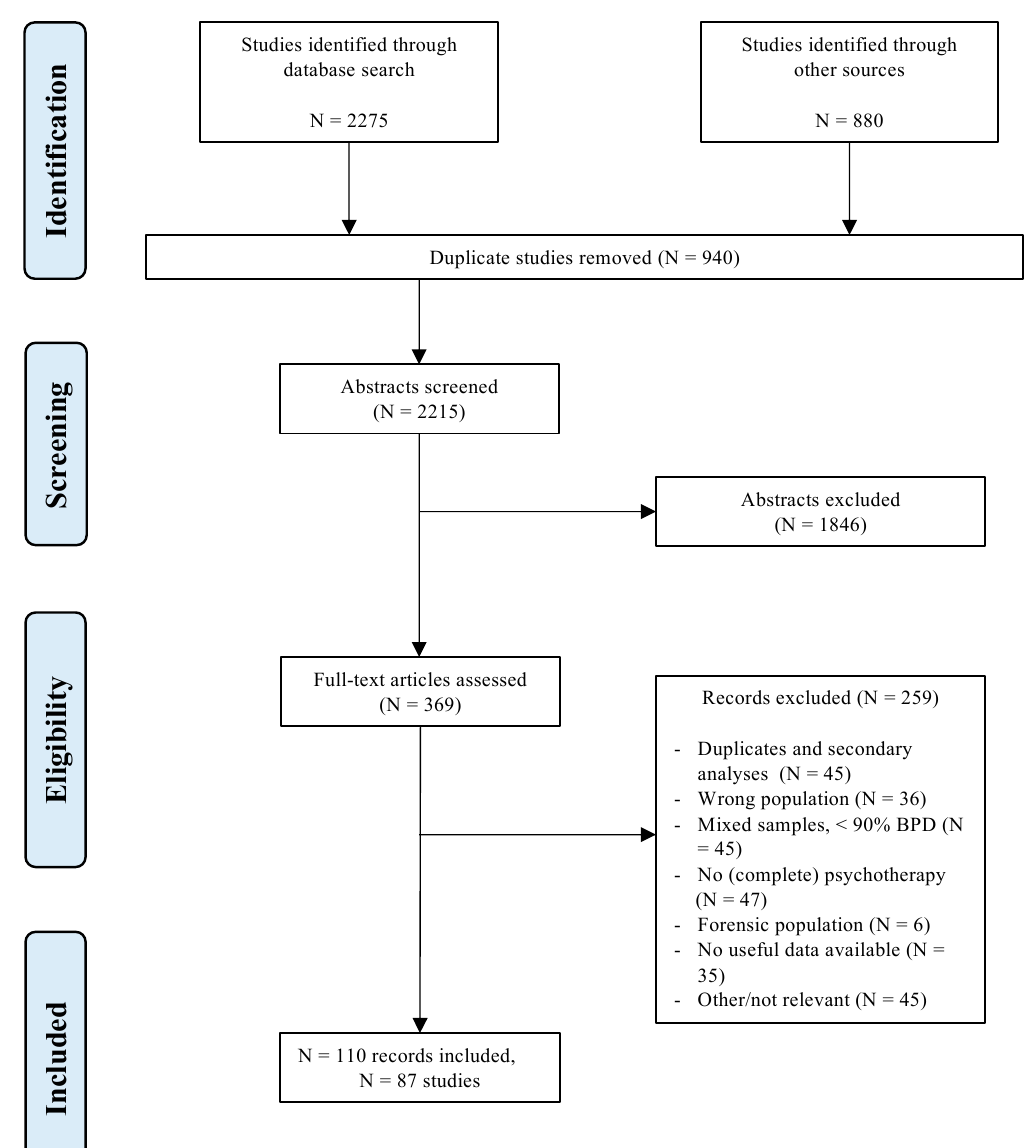
Figure 1. Flowchart of the study selection process.